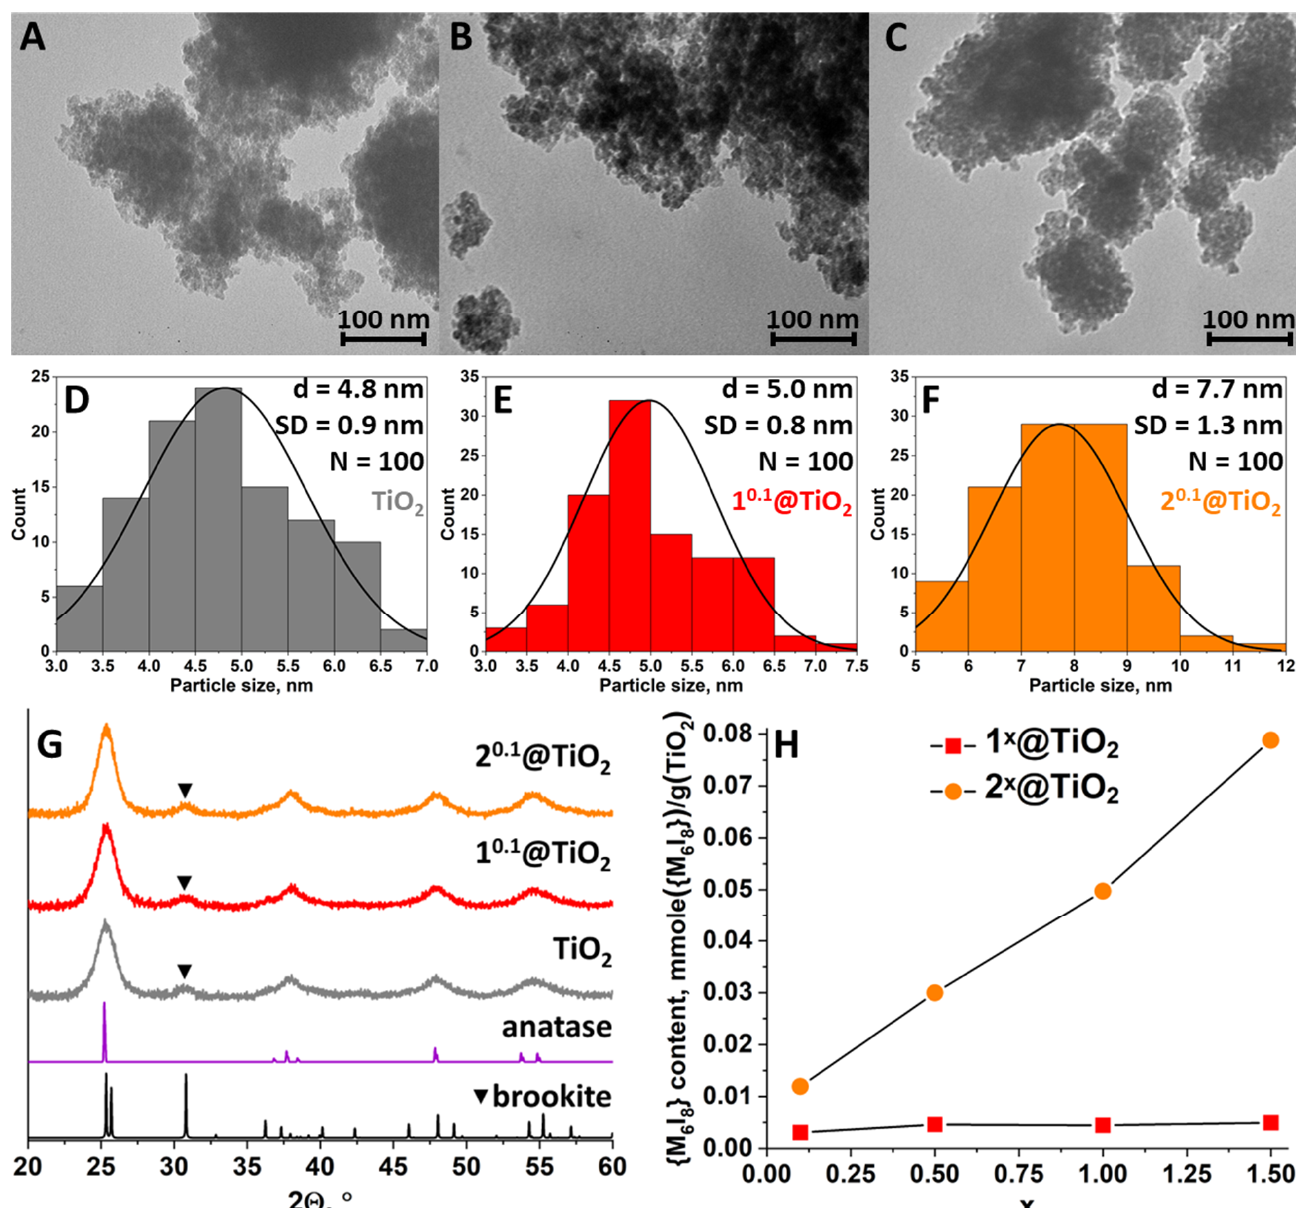
Figure 1. ( A – C ) TEM images of TiO 2 and n 0.1 @TiO 2 (n = 1 (Mo) and 2 (W)); ( D – F ) Particle size analysis using TEM images; ( G ) XRPD patterns of TiO 2 and n 0.1 @TiO 2 in comparison with calculated diffractogram of anatase and brookite (triangles refer to brookite phase reflection); ( H ) Content of {M 6 I 8 } cluster core per 1 g of TiO 2 in n x @TiO 2 determined using ICP-AES. Cluster-containing materials n x @TiO 2 (n = 1 (Mo) or 2 (W); x is the mass of the complex in gram per 1 g of TiO 2 and equal to 0.1, 0.5, 1, and 1.5) were obtained by impregnation of TiO 2 dispersion with a certain amount of cluster complexes [{Mo 6 I 8 }(DMSO) 6 ](NO 3 ) 4 (1) or [{W 6 I 8 }(DMSO) 6 ](NO 3 ) 4 (2) in water. XRPD analysis of the resulting yellowish powders demonstrates an absence of cluster-related peaks, indicating deposition of complex in